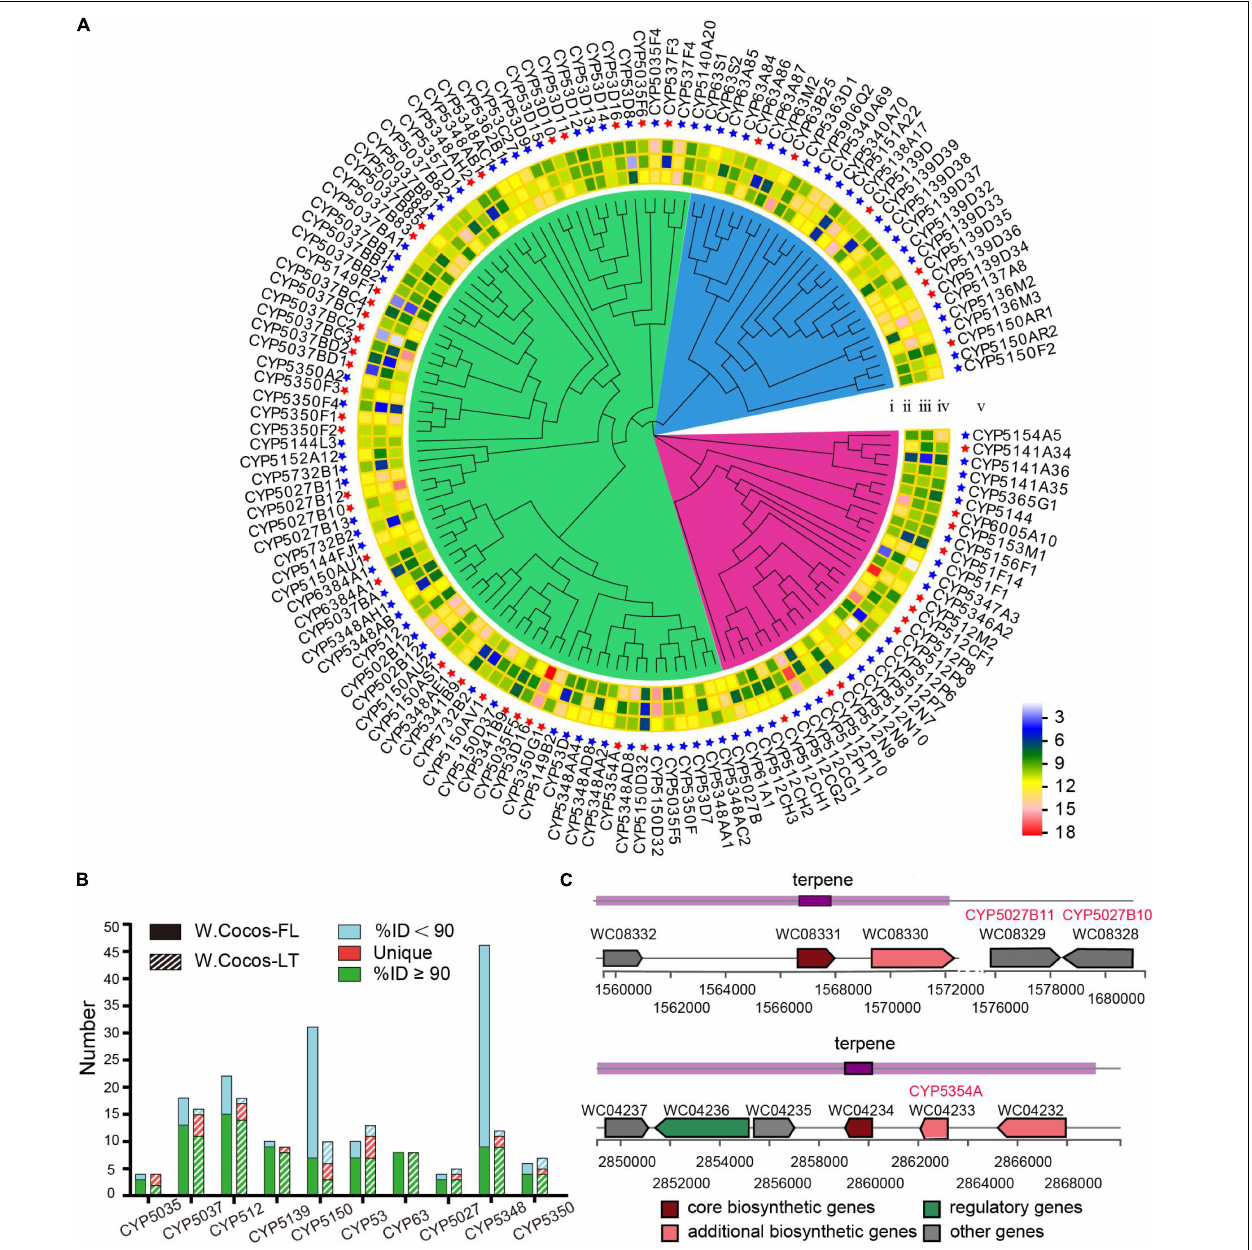
FIGURE 5 | Key genes for triterpene biosynthesis in Wolfiporia cocos. (A) A phylogenetic tree and gene expression of CYP450 gene in WCLT. (i), the phylogenetic tree of CYP450 genes in WCLT; (ii), the gene expression in EP; (iii), the gene expression in IP; (iv), the gene expression in MYC; and (v) the name of CYPs. The red star indicates the gene coexpression with LSS gene. (B) Top 10 CYP450 gene families in the WCLT and WCFL genomes. (C) A diagram of representative terpenoid synthetic gene clusters and related CYP450